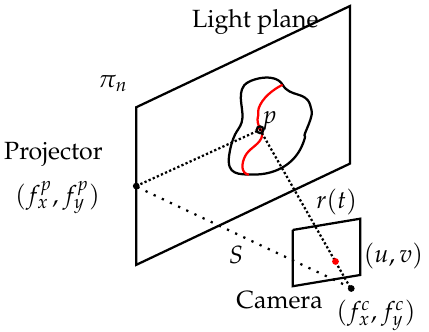
Figure 6. Triangulation geometry principle for a structured light